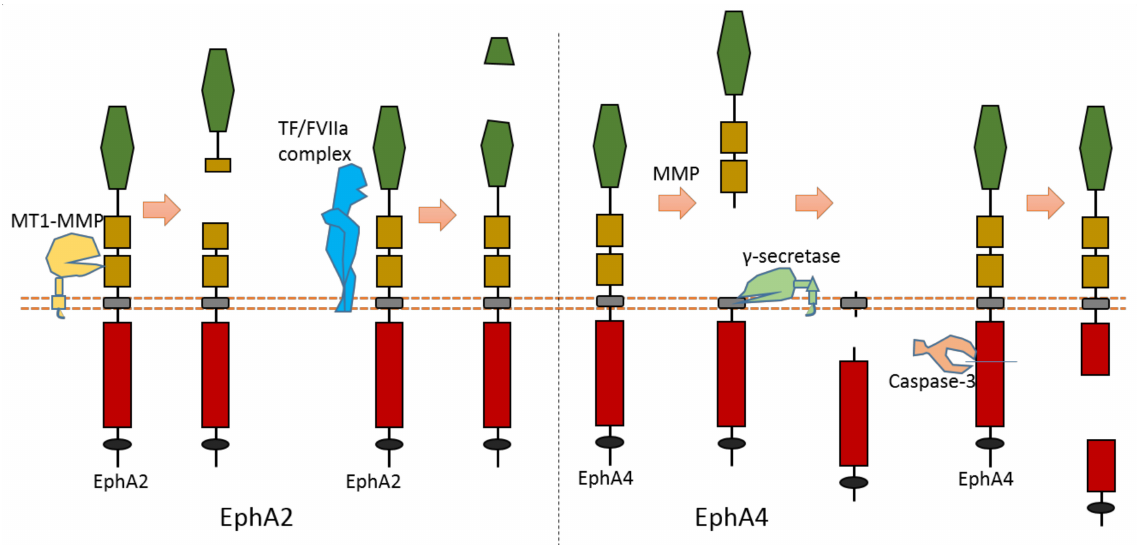
Figure 6. Schematic illustration of proteolytic cleavage in in EphA2 and